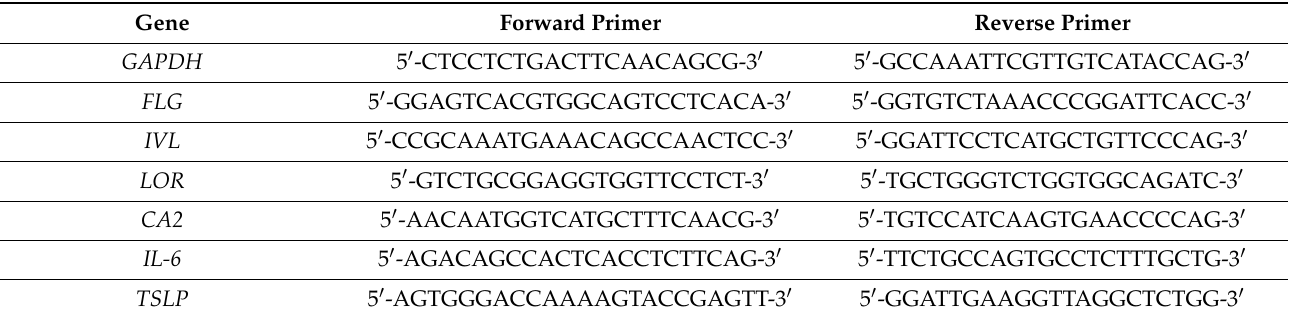
Table 2. List of sequence of primers for Real-time quantitative